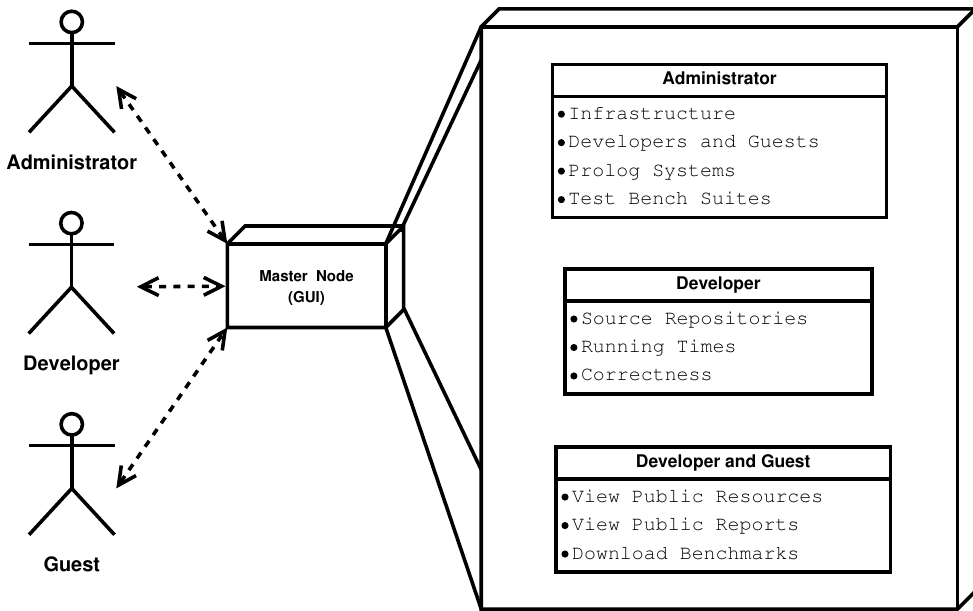
Figure 6. Users and services